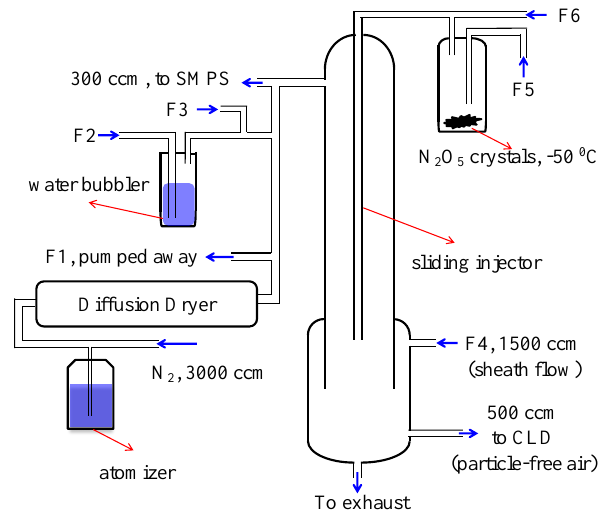
Figure 1. Schematic diagram of the aerosol flow tube. SMPS: scanning mobility particle sizer; CLD: chemiluminescence detector, used to measure the N 2 O 5 concentration (measured as the change in the NO concentration). All the flows (except the flow applied to the atomizer) were controlled by mass flow controllers. Flow details are provided in text.